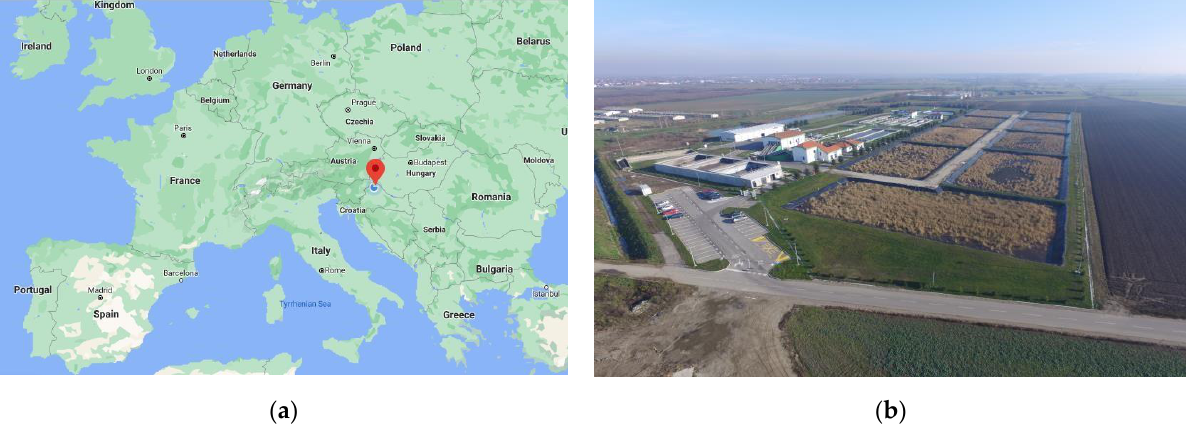
Figure 1. ( a ) Location of the wastewater treatment plant in Čakovec; ( b ) Closer view of the wastewater treatment plant in Čakovec.